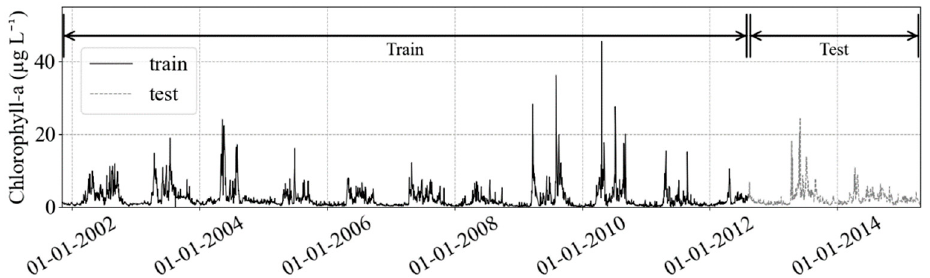
Figure 2. The train and test partition in chlorophyll-a concentration target (black solid and gray solid lines, respectively), and the HPLC chl-a validation dataset (black dashed). After the split, the testing dataset will remain untouched, to guarantee no leakage of information to the training step. The validation dataset is the independent validation.